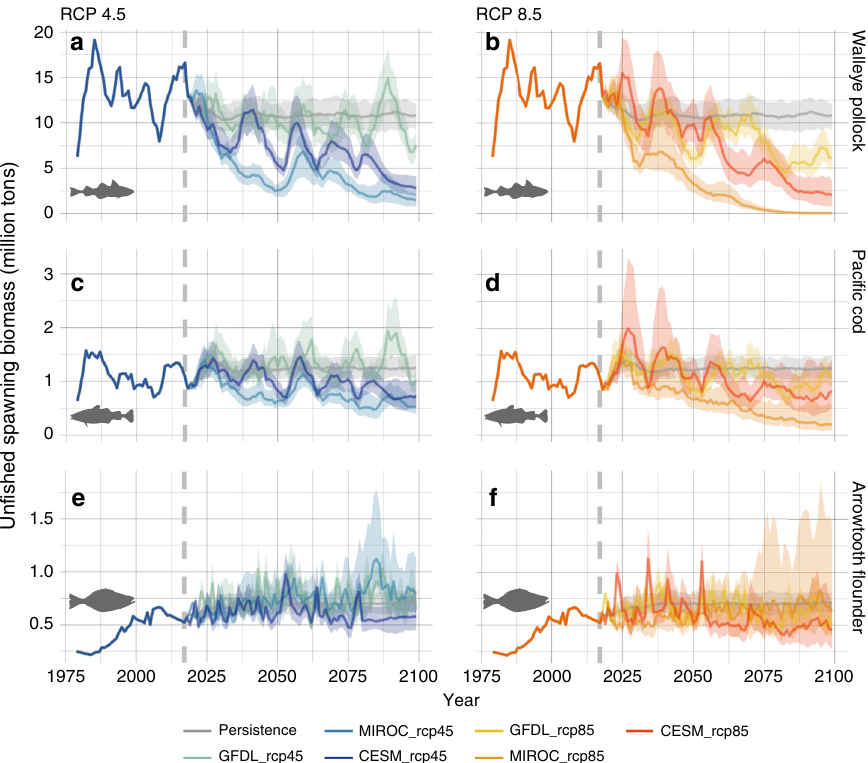
Fig. 3 Future un fi shed spawning stock biomass. Un fi shed spawning stock biomass for pollock ( a , b ), Paci fi c cod ( c , d ), and arrowtooth fl ounder ( e , f ) under future climate change scenarios: moderate mitigation (RCP 4.5; left column), high-baseline emissions (RCP 8.5; right column), and a persistence baseline climatology (solid gray lines in each panel). Vertical dashed line represents the start of the projection period (2018 – 2100). Solid lines represent the 50th quantile, while shading indicates the 10th and 90th quantiles from 100 random draws from estimated recruitment